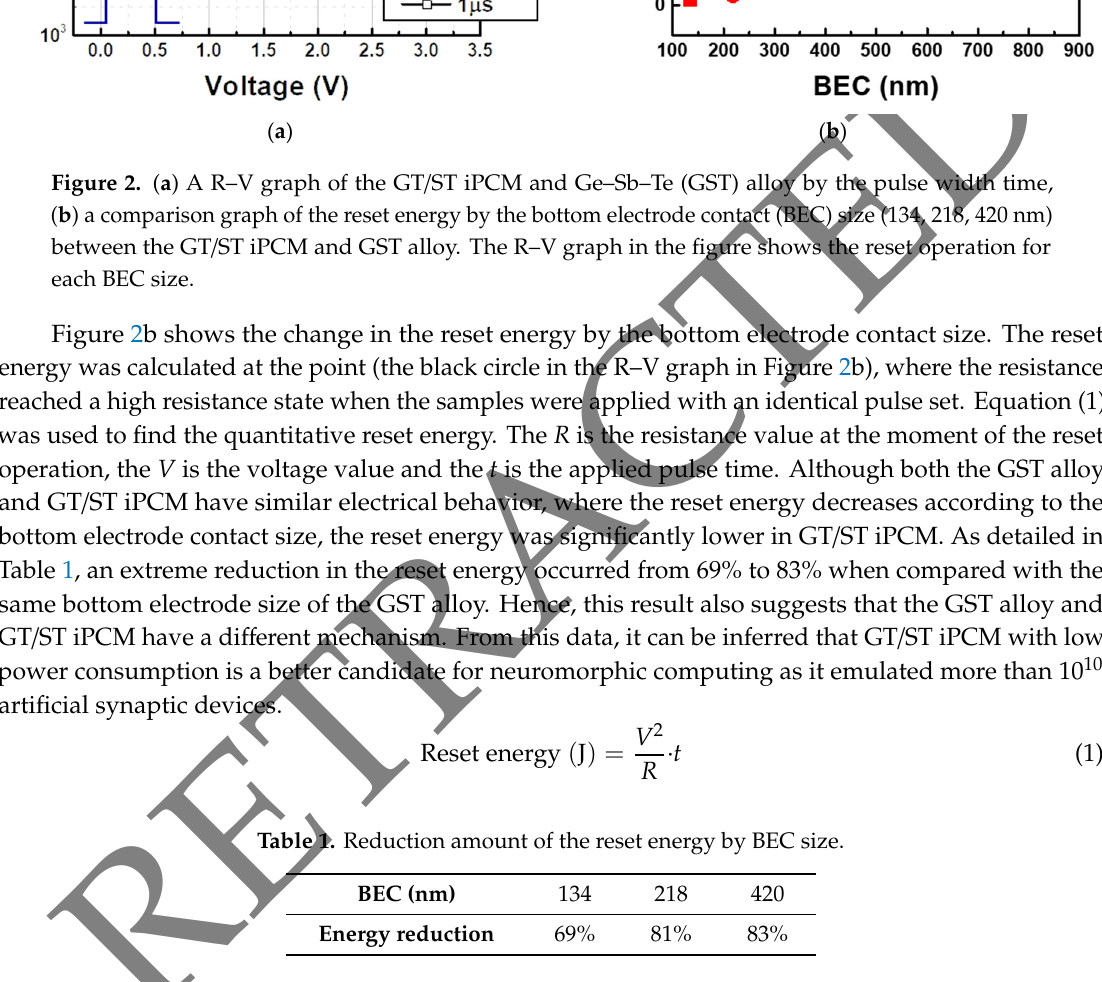
Table 1. Reduction amount of the reset energy by BEC